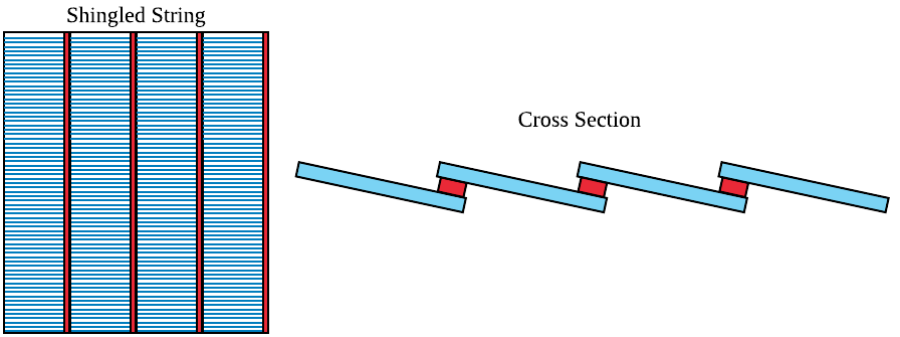
Figure 12. Shingle PV module interconnection.